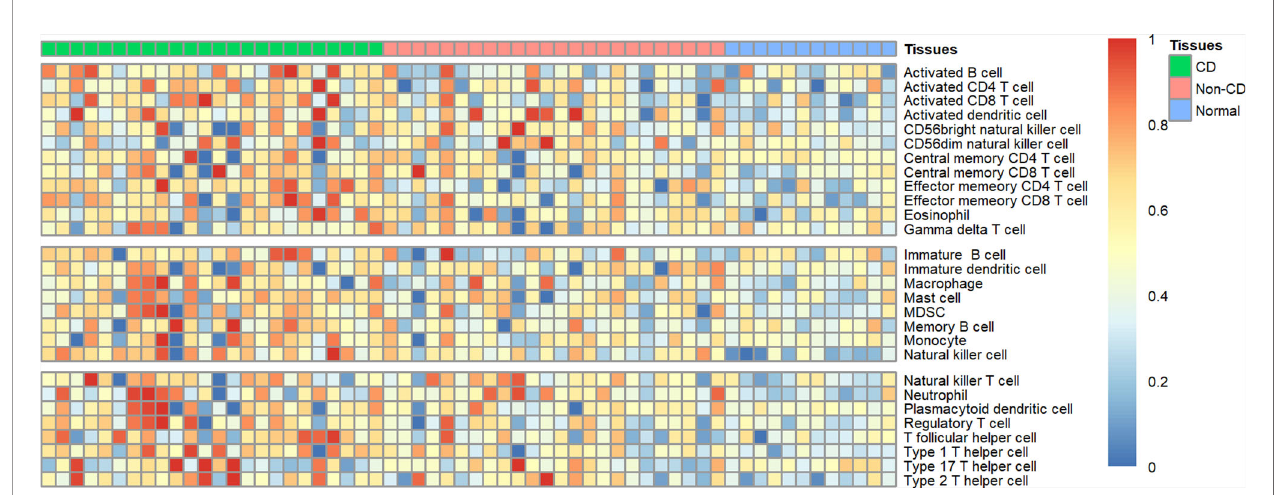
FIGURE 1 | Heatmap of the landscape of 28 immune cell subpopulations in fi ltration in CD (n=60